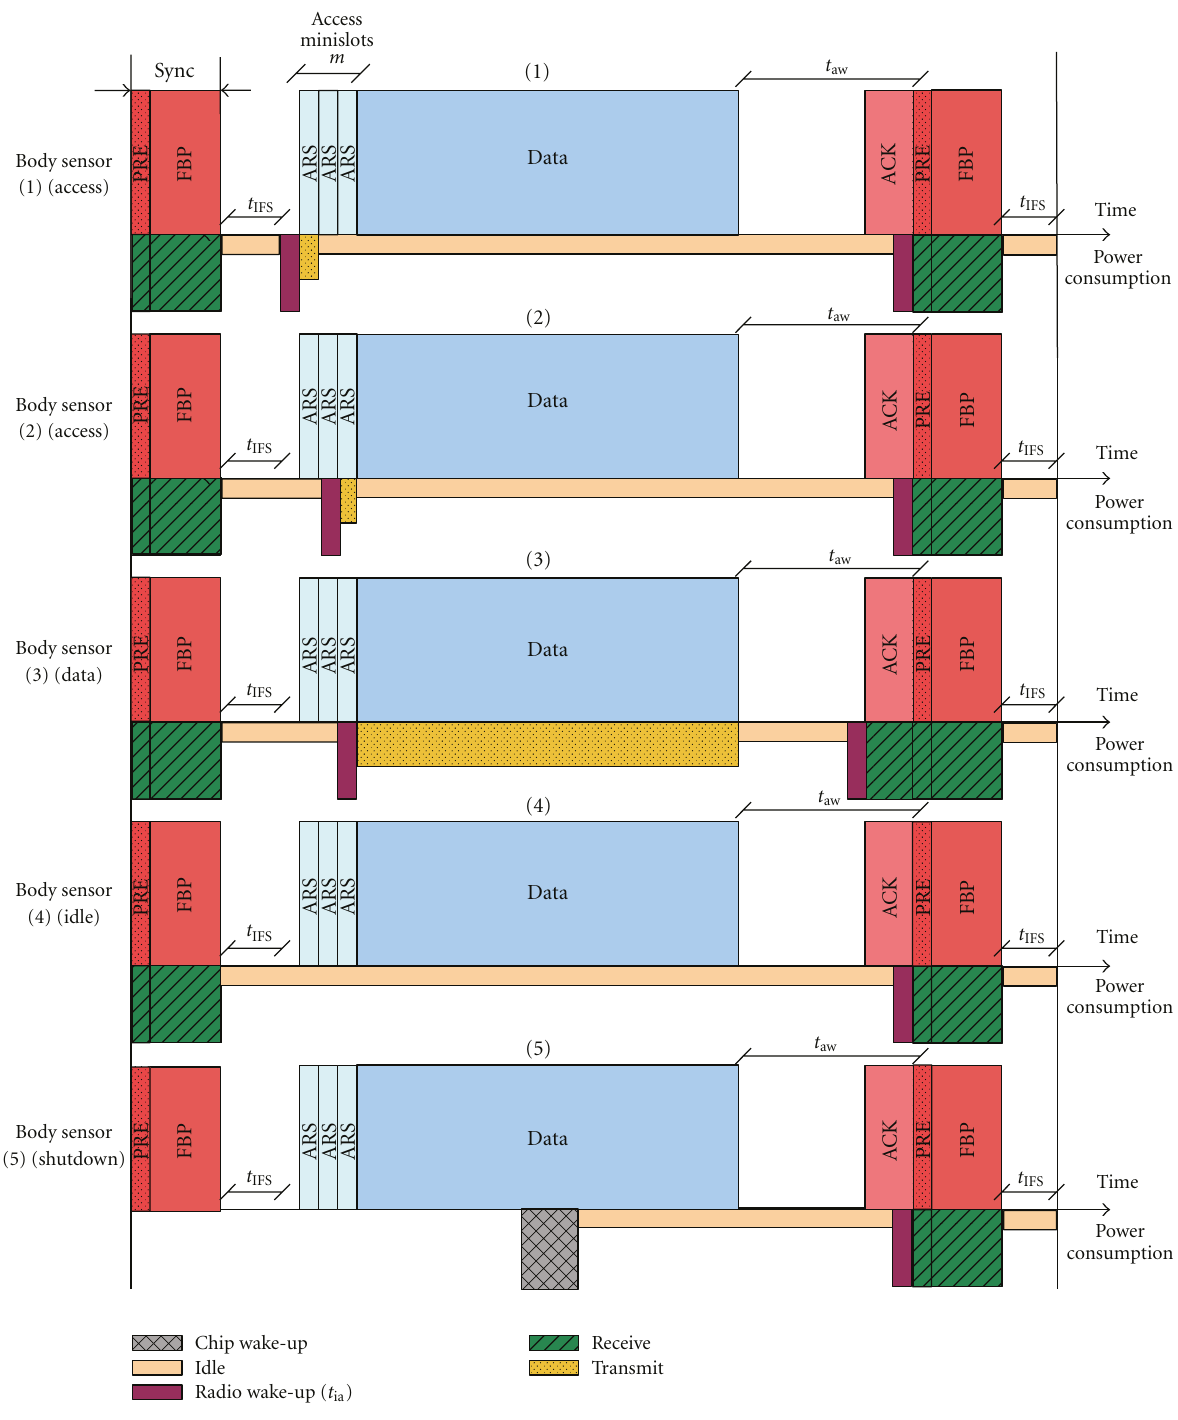
Figure 5: Power management scenarios for di ff erent body sensors using